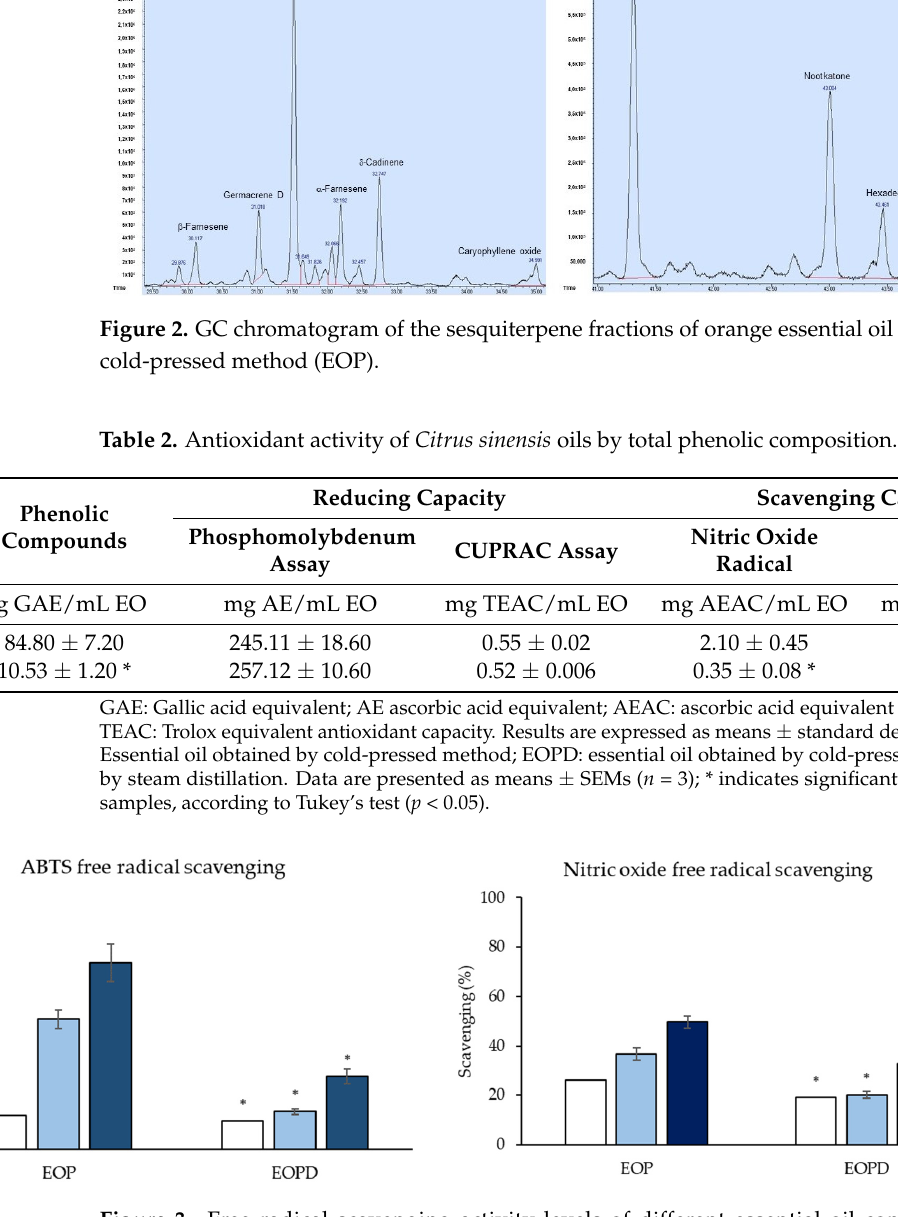
Figure 3. Free radical scavenging activity levels of different essential oil concentrations.